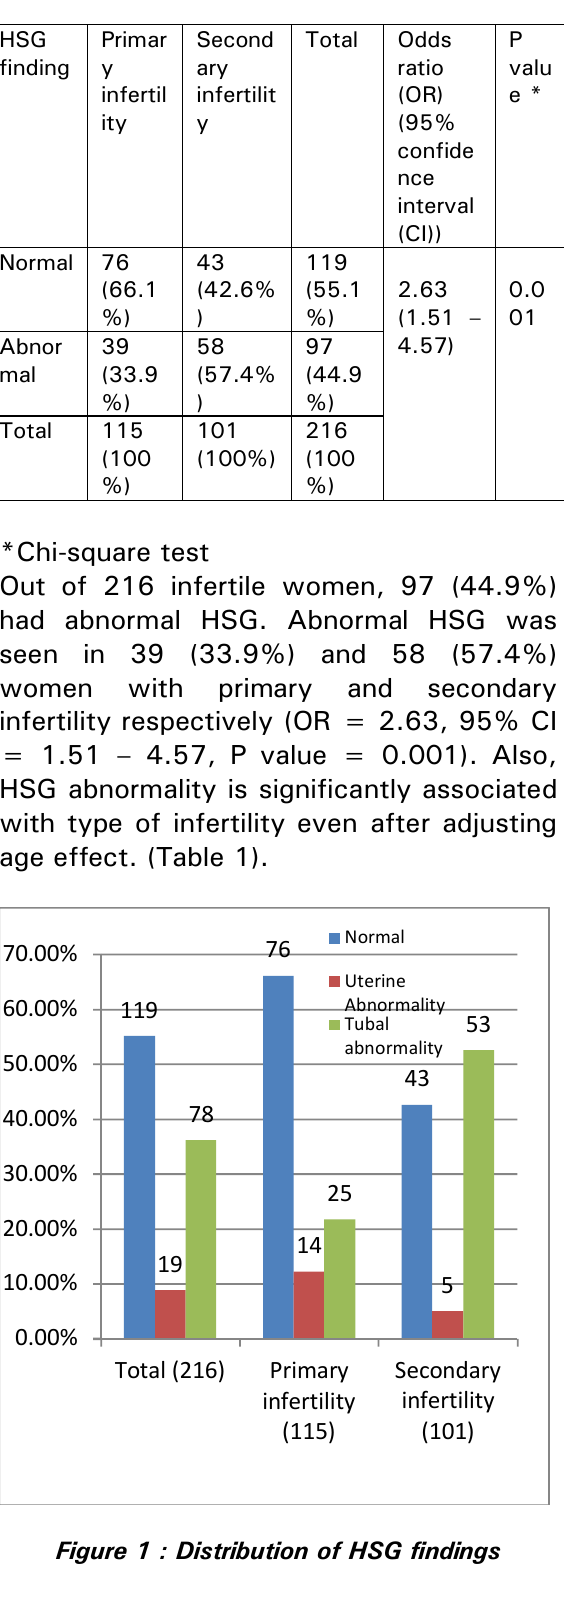
Table 1:HSG findings with type of infertility